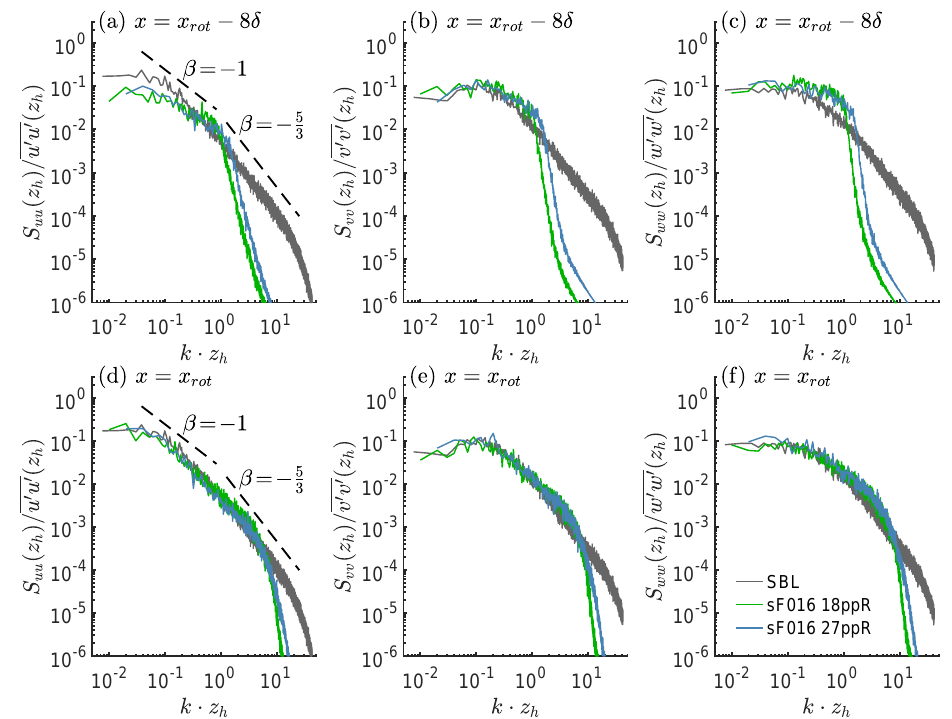
Figure 9. Normalized energy spectral density of the three velocity components at the rotor center ( z ) / u (cid:48) ( z ) with i = j , within simulated boundary layers and experimental SBL configuration: S u u (cid:48) h h i j i u j ( a , d ) u − component; ( b , e ) v − component and ( c , f ) w − component. The legend denotes flow conditions, dashed lines denote the slope of the Kolmogorov